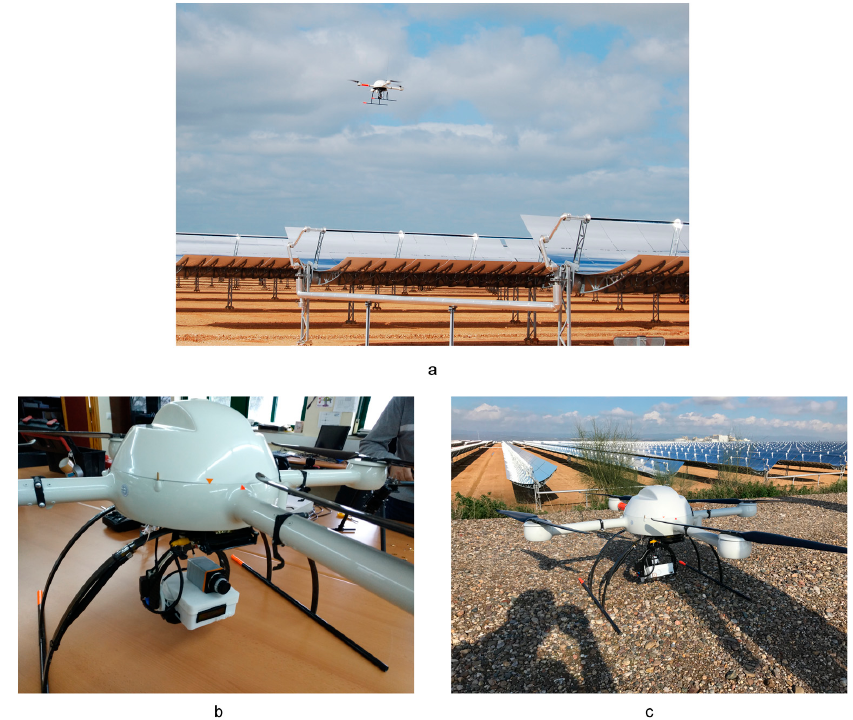
Figure 6. ( a ) The UAV performing an inspection on a concentrated solar power (CSP) plant; ( b ) Front view of the system onboard the UAV; ( c ) Back view of the system onboard.